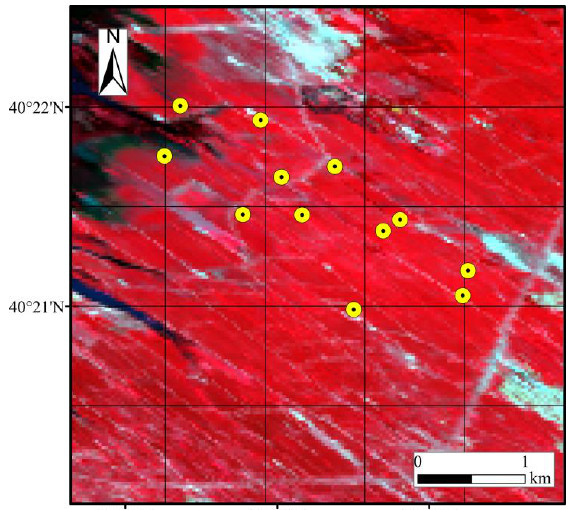
Figure 1. Map of the study area overlaid by the MOD15A2 product pixels (nominal resolution of 1 km × 1 km). The displayed image corresponds to a color composite (bands 5-4-3) of Landsat-8 OLI image acquired on August 23, 2013. The points represent the locations of the plots in the LAINet observation system deployed in the study